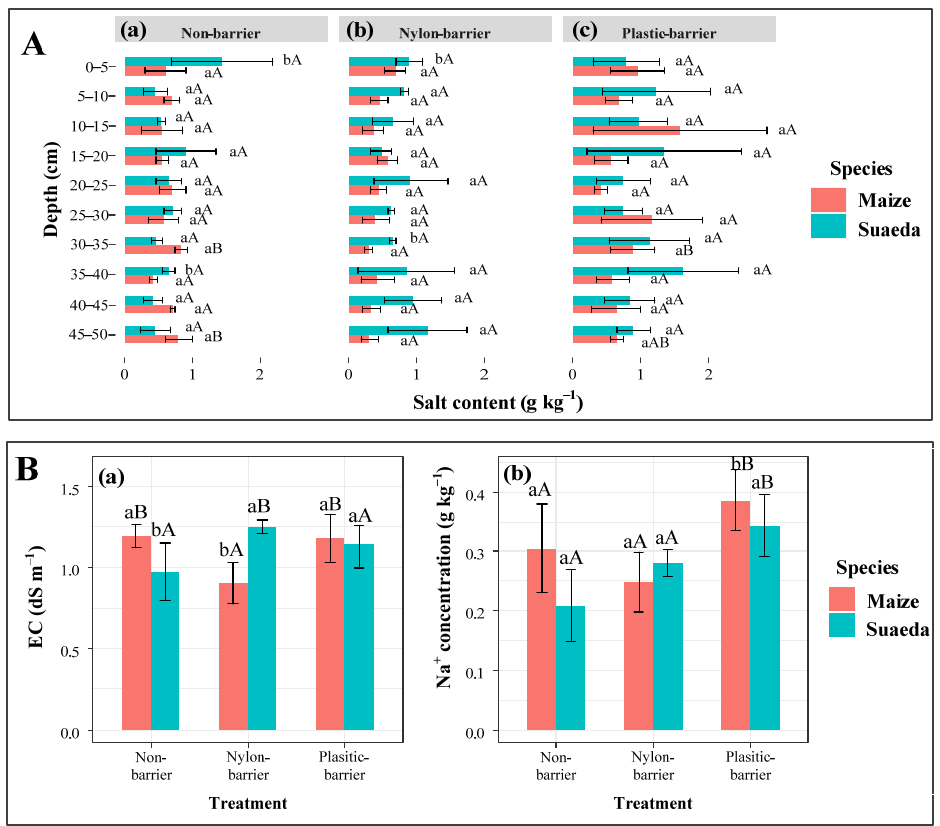
Figure 4. The soil salt, EC, and Na + in the different treatments: ( A ( a – c )) Salt content in non-, nylon-, and plastic-barrier treatment of field experiment; ( B ( a , b )) EC, Na + content of pot experiment. Capital letters on the column indicate the significant difference differences among three treatments. Lower case letters on the column indicate significant differences between two species.